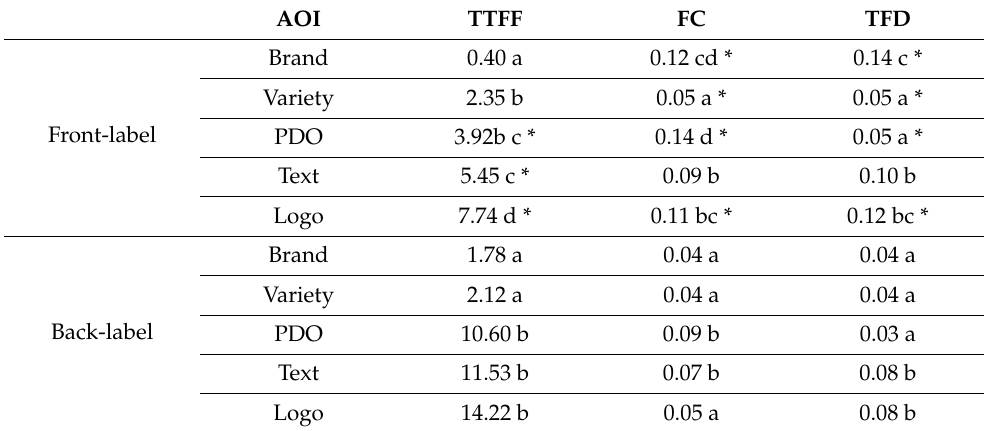
Table 4. Eye-tracker metrics for the different AOIs. TTFF-time for first fixation, FC-fixation counts, TFD-total fixation